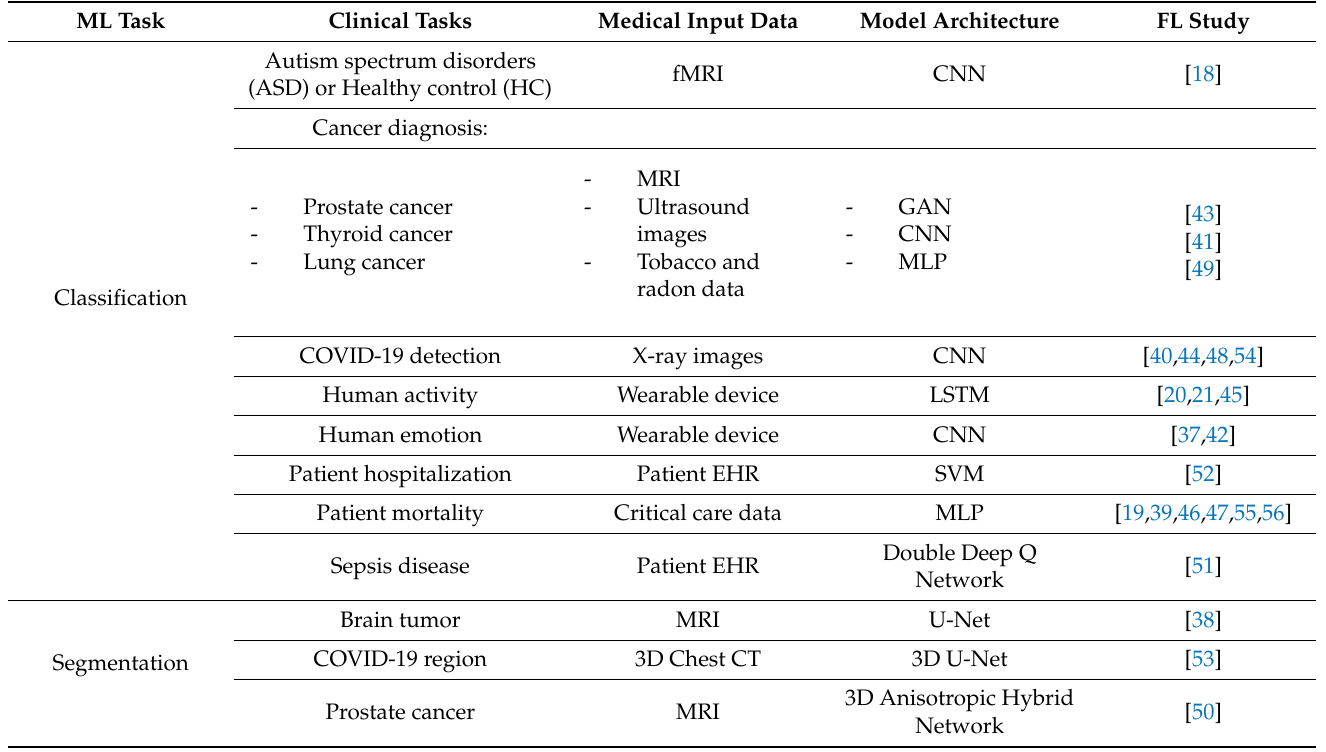
Table 5. Summary of FL publications applied in medical